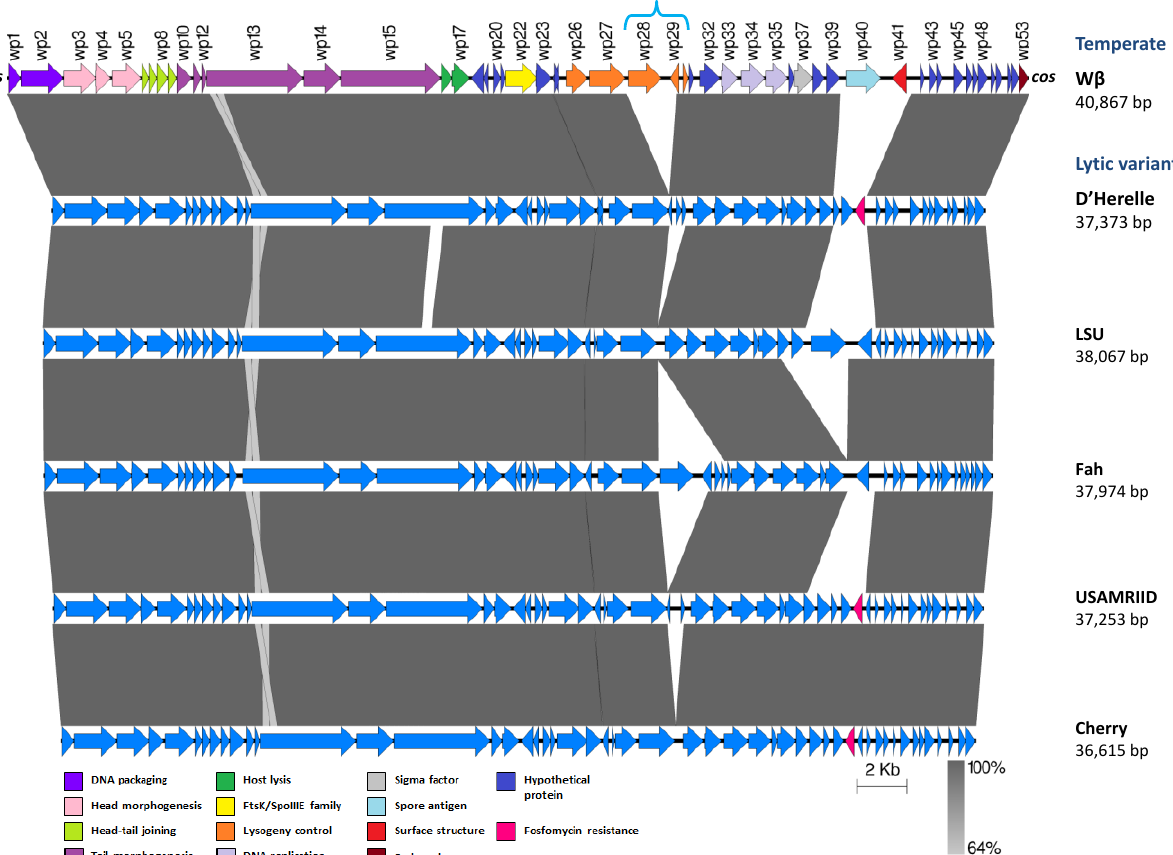
Figure 4. Genome comparisons of γ-like isolates. Predicted genes and direction of transcription are represented as block arrows. For phage Wβ, ORFs are colored according to gene function, as indicated by legend at the bottom. wp indicates numerical gene designations for phage Wβ. Conserved regions are grey-shaded, the color intensity indicating the nucleotide identity levels (from 64% to 100%). The comparisons were done by BLASTn, and similarities with E values lower than 0.001 were plotted. Blue brace above wp28 and wp29 indicates the genes affected by the deletion in the lysogeny control module that characterize the lytic γ-like isolates. When present, Fosfomycin resistant gene is indicated by magenta ORFs (arrows) in the lytic isolates. For further description, see the main text. The figure was produced using Easyfig 2.1 program [171] using data extracted from GenBank annotations and from [118,120]. GenBank accession numbers are listed in Table